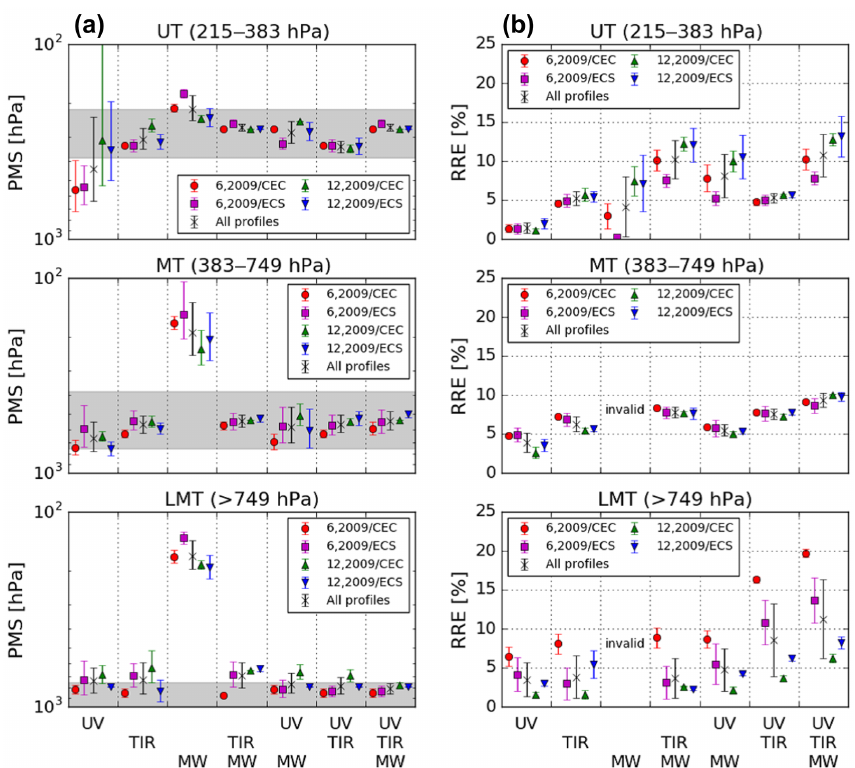
Figure 4. Same as Fig. 3 but for the PMS (a) and RRE (b) . The gray shaded area represents the vertical region that corresponds to UT, MT, and LMT. Table 5. Comparison of DFS in the LMT region with those of previous studies. Method and scenarios differed, so relative difference